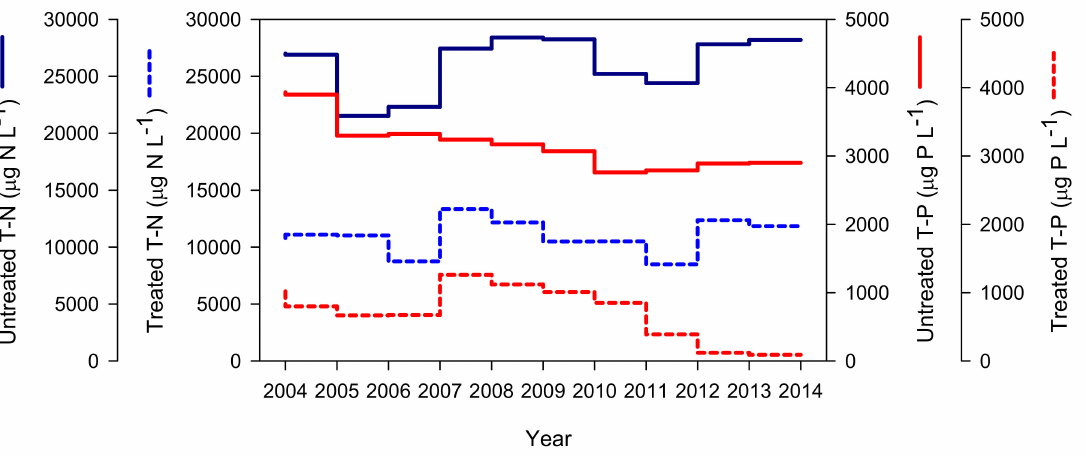
Figure 4. Comparison of the annual mean total nitrogen (TN) and total phosphorus (TP) concen- trations in the untreated and treated wastewaters of the Chuncheon wastewater treatment plant located in the Euiam Reservoir watershed from 2004 to 2014. Chemical treatments to mitigate the total phosphorus load began in 2011 to 2012. Data were collected from the Annual Report of National Wastewater Statistics published by the Ministry of Environment (MOE), Republic of